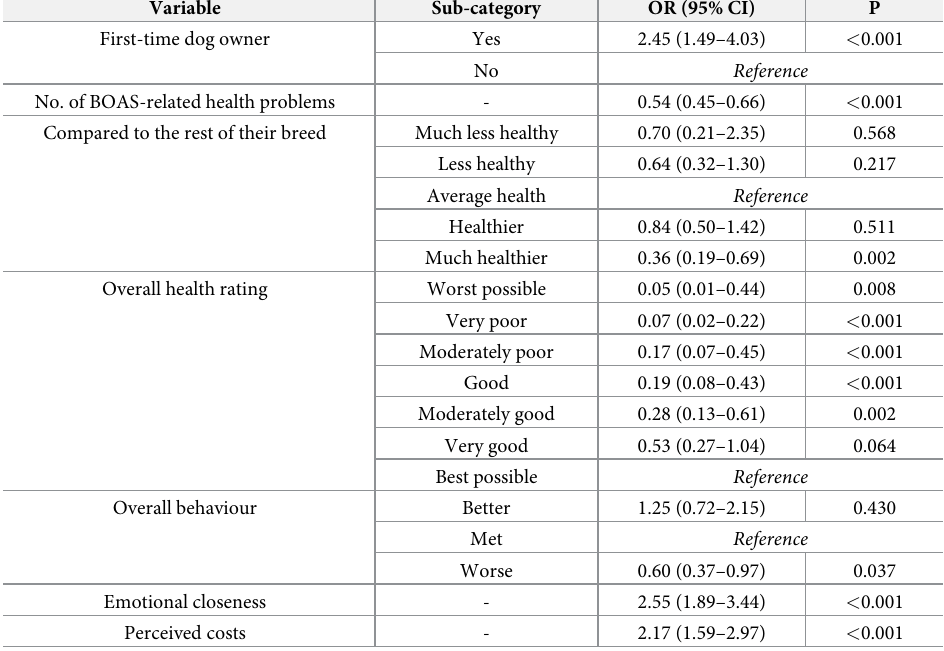
Table 1. Results of multivariable binary logistic regression for risk factors associated with owner desire to reac- quire their current breed.